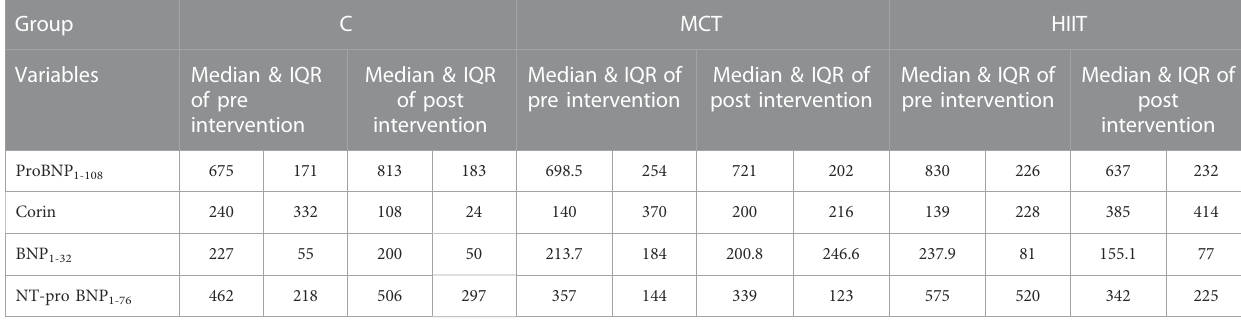
TABLE 5 Median and IQR of Pre-intervention and Post-intervention of variables in groups. Group C MCT HIIT